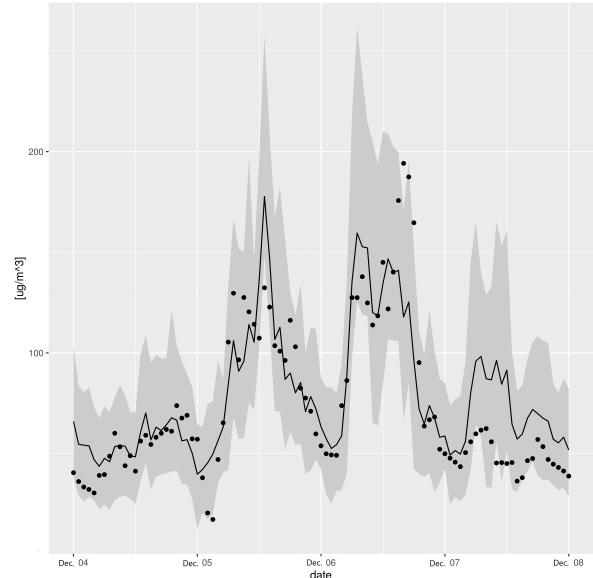
Figure 6. Sample of observation (dots) timeseries with the RFreg prediction (line), the error prediction at CI95 (gray area) following Eaamm 2010 at station 7 between 4 December 2016 and 8 December 2016 ( upper left ), following Wager 2014 at station 7 between 4 December 2016 and 8 December 2016 ( upper right ), following Lu 2019 at station 7 between 4 December 2016 and 8 December 2016 ( lower ).